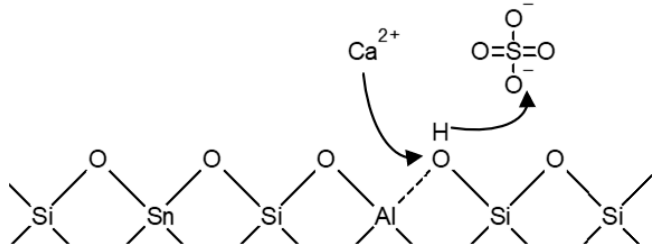
Figure 8. The proposed mechanism by which calcium sulfate modifies the Sn-Beta catalyst.